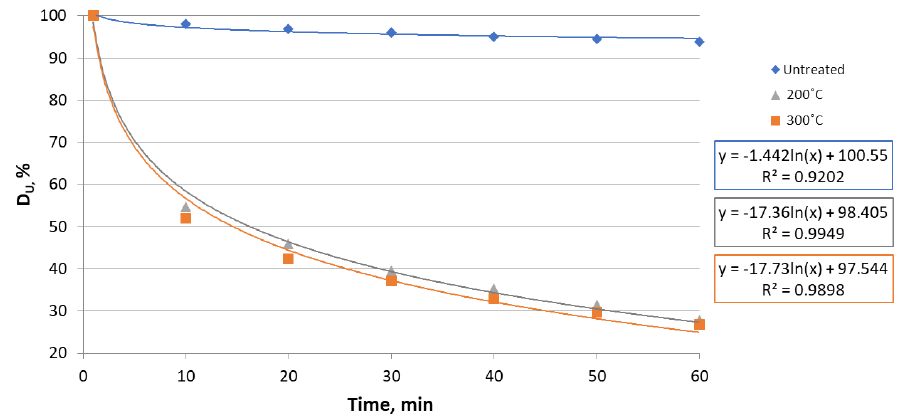
Figure 8. Mechanical durability of untreated and torrefied pine pellets.